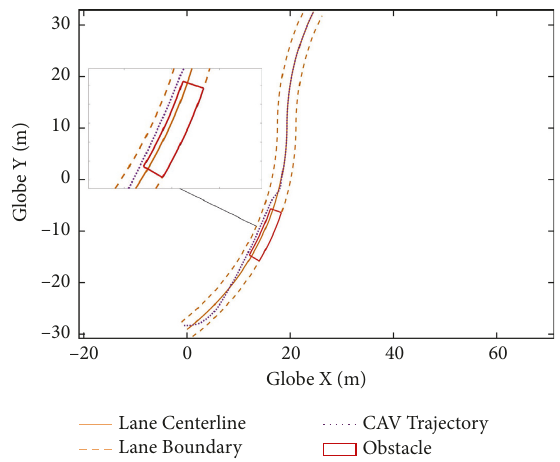
and p values. 1 2